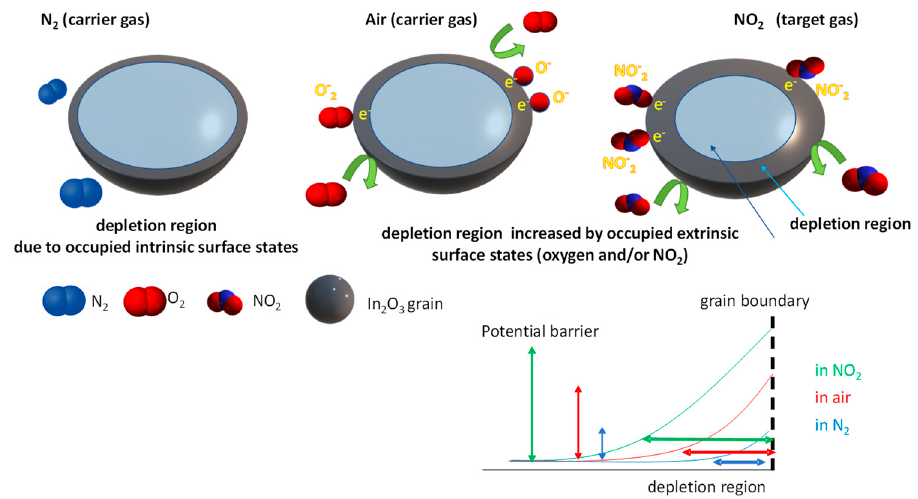
Figure 1. Gas absorption mechanism in In 2 O 3 nano-grained material.